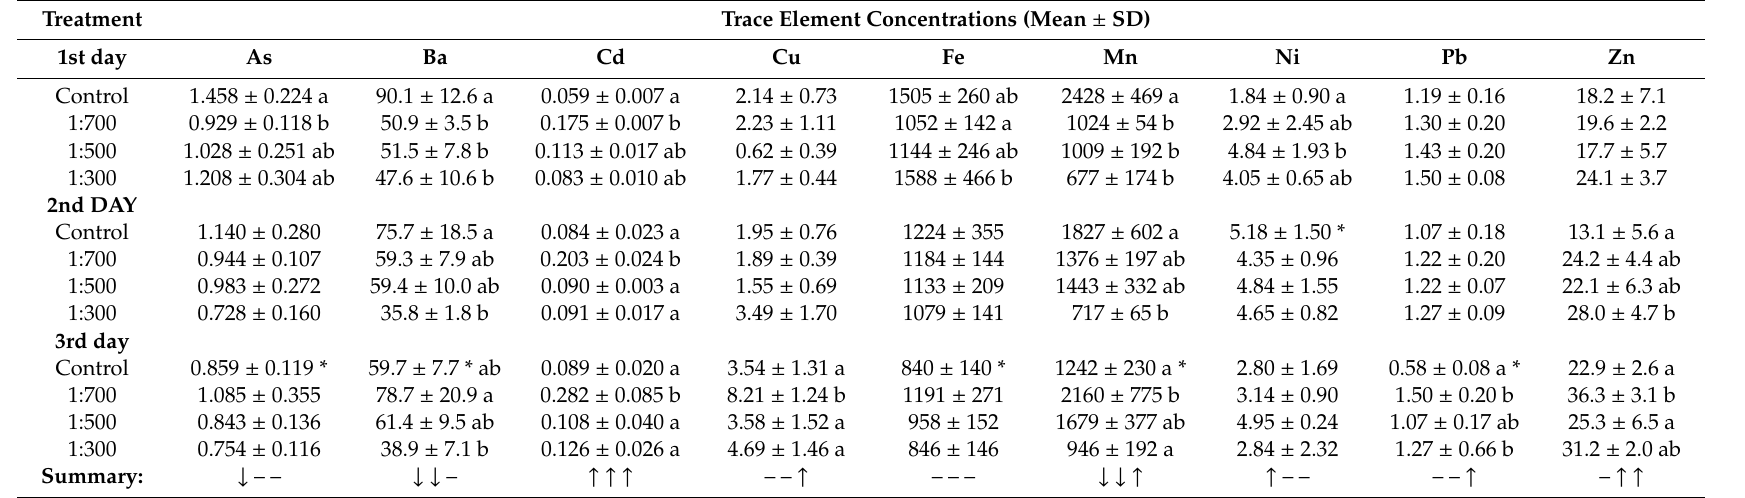
Table 1. Mean concentrations ( µ g / g dw ± standard deviation) of trace elements detected in the aquatic fern Azolla filiculoides after the first, second and third day of incubation in mineral water (control) and 1:700, 1:500 and 1:300 wood distillate solutions (N = 3). For each day, statistically significant ( p < 0.05) di ff erences between treatments are indicated by di ff erent letters. Asterisks mark control values of the second and third day which are significantly di ff erent from the control values of the first day. For each day, arrows summarize the overall pattern ( ↑ uptake, ↓ release, – not relevant) of significant changes respect to their